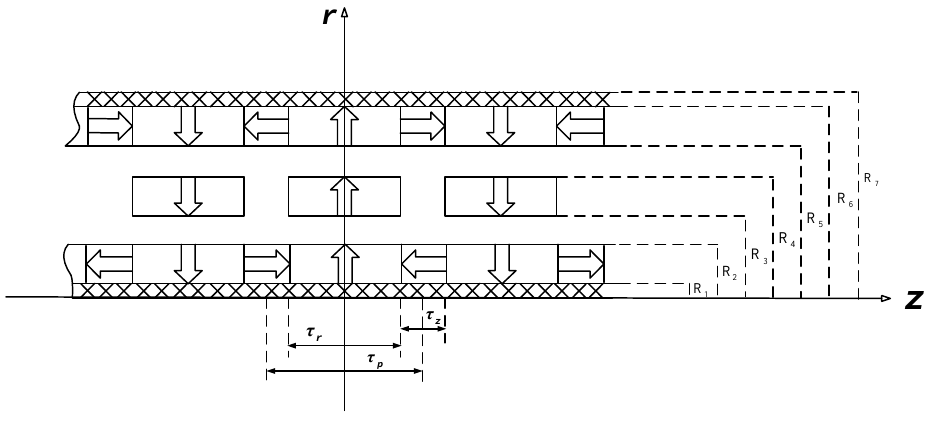
Figure 5. Major structural parameters of the proposed linear machine.